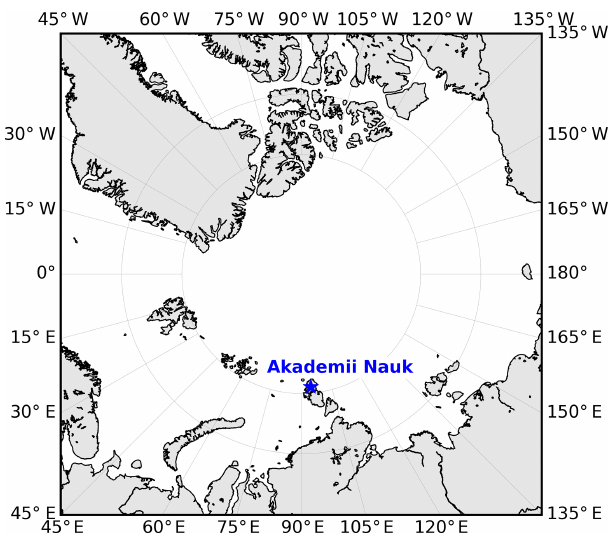
Figure 1. Location of Akademii Nauk ice core drilling site (80 ◦ 31 (cid:48) N, 94 ◦ 49 (cid:48)